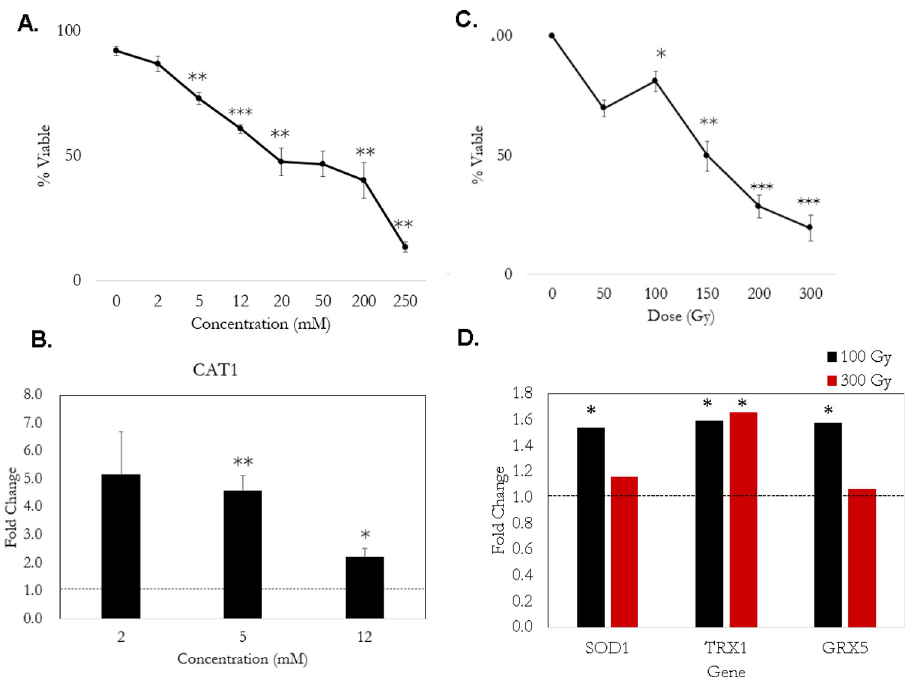
Fig 1. The IR and H 2 O 2 conditions tested affect viability and gene expression of oxidative response transcripts. A. The percent viability curve in C . neoformans exposed to increasing concentrations of H 2 O 2 . Exposure was for 1 hour and viability was assessed using a trypan blue exclusion assay. Three biological replicates were considered for each dose and the error bars are the standard error of the mean (SEM). Significance was determined using a Student’s t-test and a p-value < 0.05. B. The fold change of catalase 1 (CAT1) gene expression in response to 2 mM, 5 mM, and 12 mM H 2 O 2 for three biological replicates. Significance was determined by Student’s t-test with a p-value < 0.05. C. The average percent viability of C . neoformans exposed to increasing doses of IR via 60 Co exposure for three biological replicates. Viability was assessed via colony forming units (CFUs) and error bars are SEM. Significance was determined using a Student’s t-test with a p-value < 0.05. D. Fold change of enzymes involved in IR response as determined by transcriptomics for two replicates. The significant differentially expressed genes versus no exposure controls were determined using EBseq and a fold change cutoff of 1.5 and p-value < 0.05.